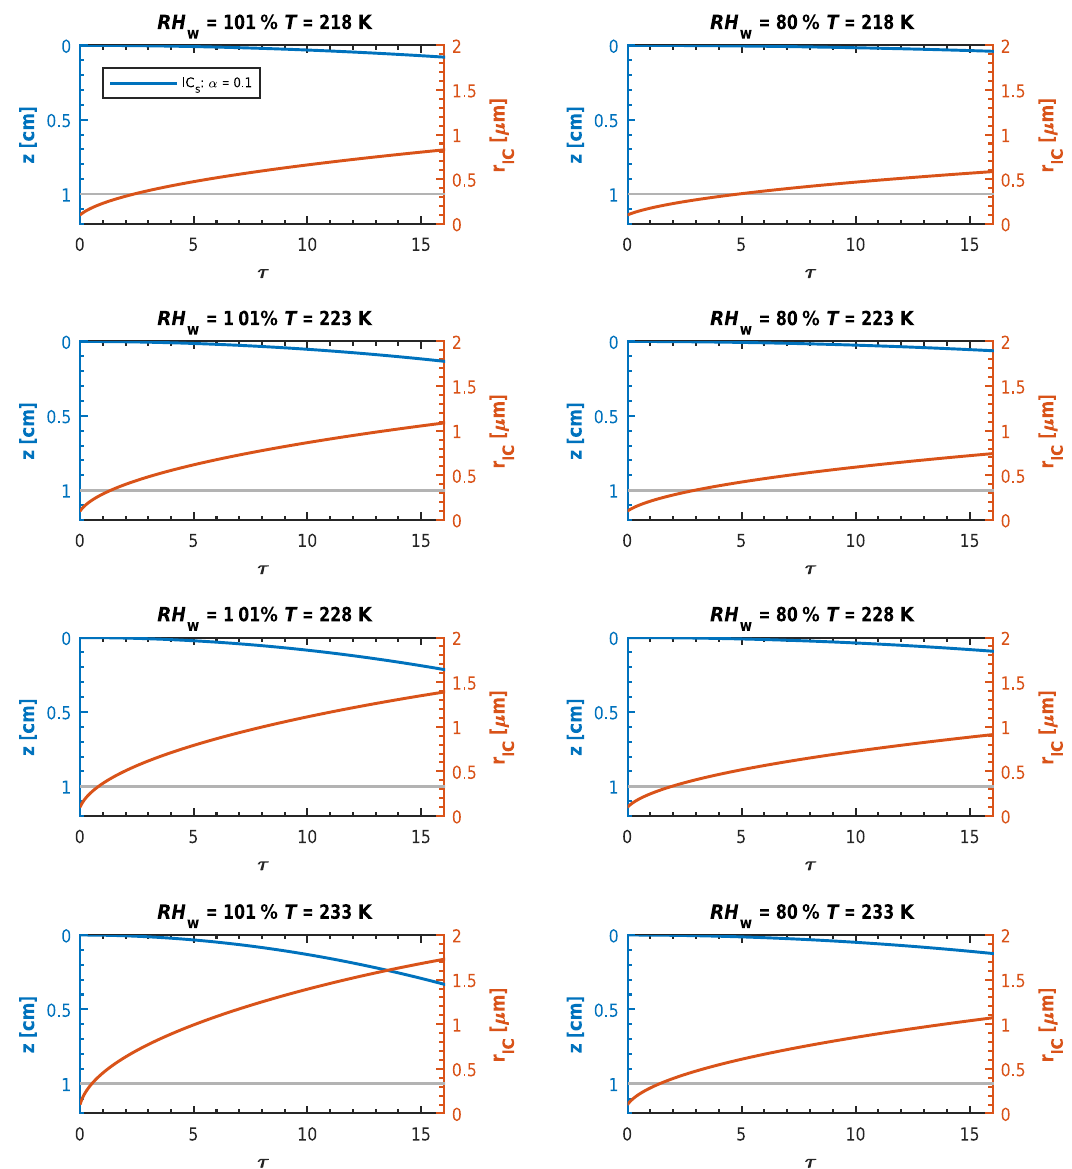
Figure D3. Expected diffusional growth of spherical ice crystals, having an initial diameter of 200nm, within HINC for different cirrus regime temperatures, T center (rows), and RH w along the centerline of HINC (columns), as a function of residence time. Orange lines indicate the ice crystal radius (right-hand ordinate). Blue lines indicate the vertical distance covered by the ice crystal (left-hand ordinate). Calculations are aborted once a particle has traveled the half-distance of the two copper plates (1cm), i.e., once it has hit the bottom plate of HINC, indicated by the horizontal, gray line (left-hand ordinate), i.e., wherever any blue line crosses the horizontal gray